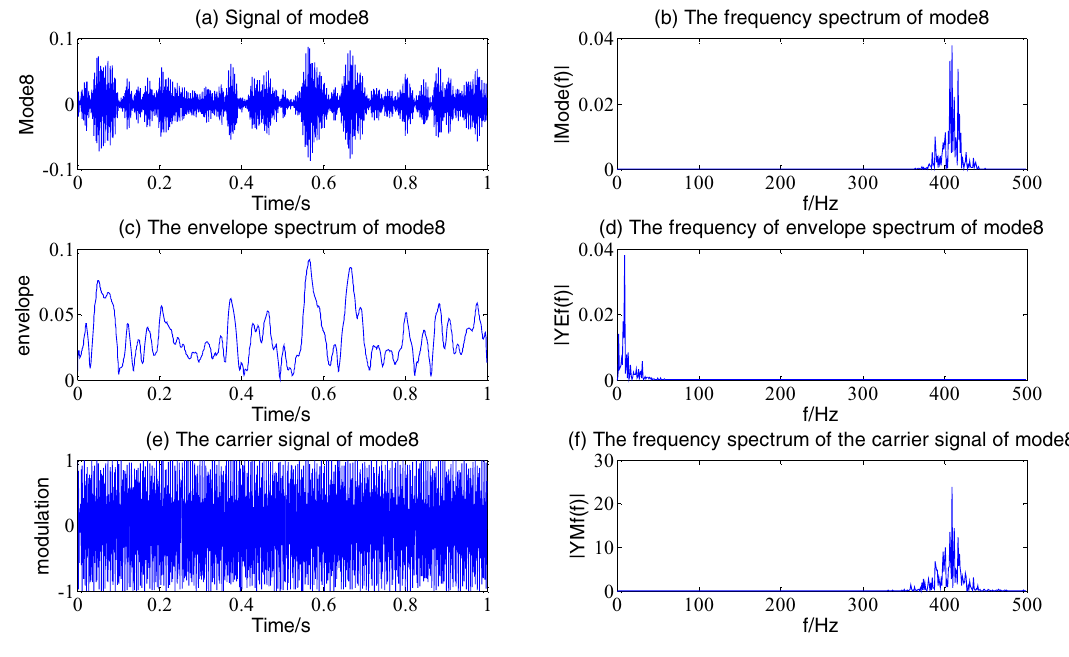
Figure 16. The envelope demodulation distribution diagram of